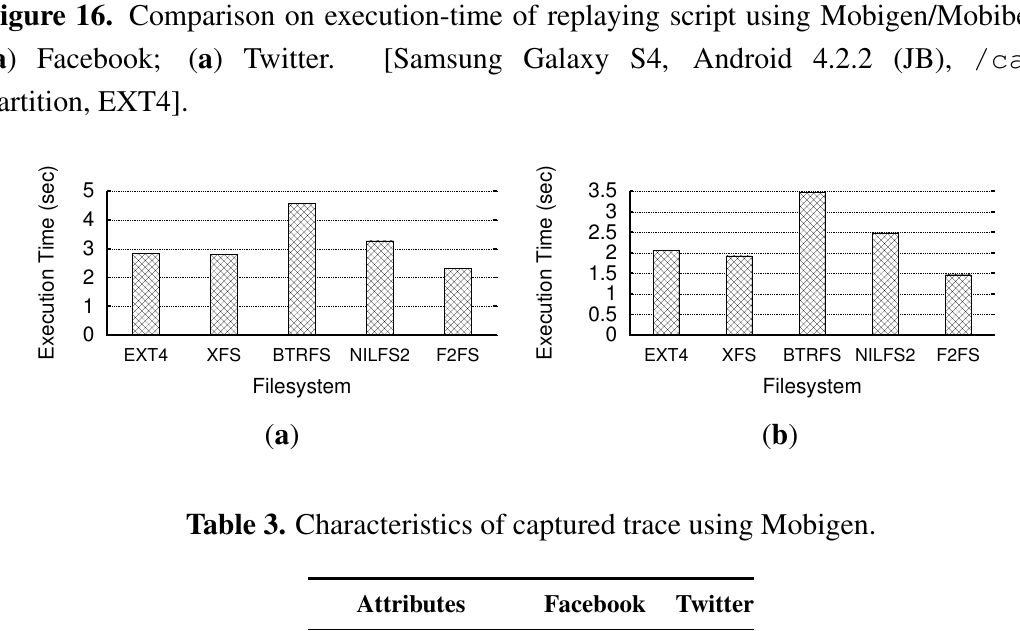
Figure 16. Comparison on execution-time of replaying script using Mobigen/Mobibench.